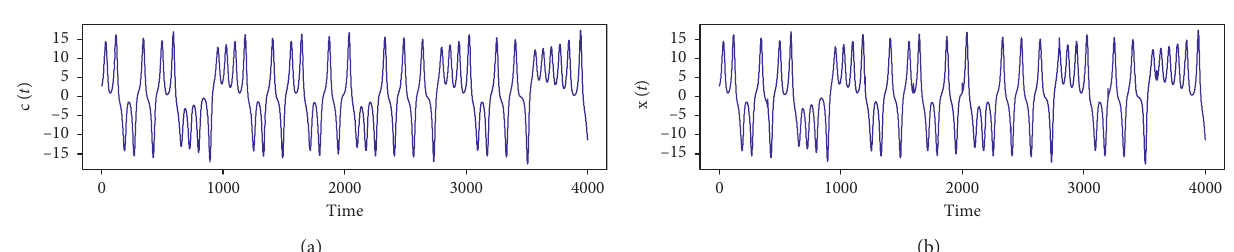
Figure 4: Data display diagram. (a) Chaotic noise c ( t ) . (b) Original data x ( t )